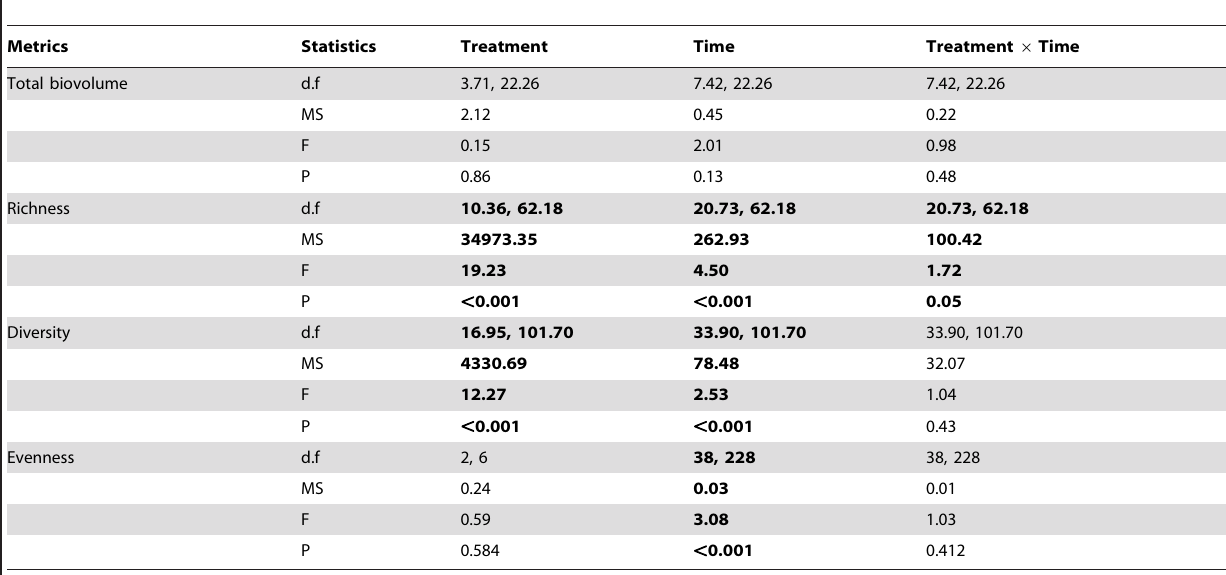
Table 1. Results of repeated-measures ANOVA contrasting phytoplankton community metrics (total biovolume, richness, diversity and evenness) between lakes (circum-neutral, acidified and limed), time (year) and their interactions.